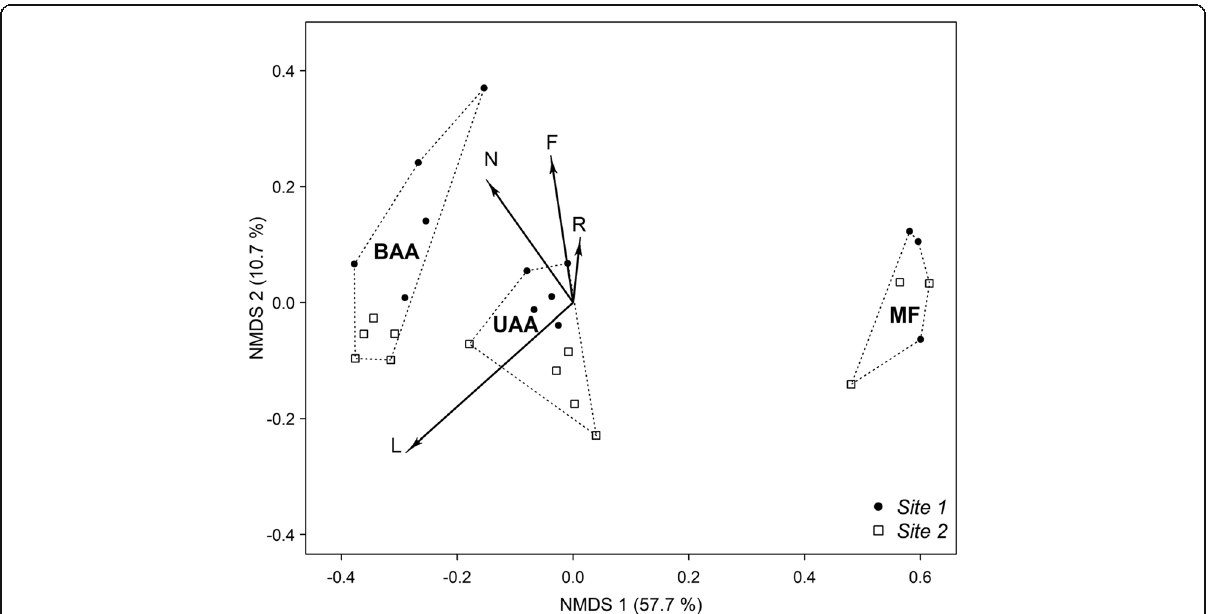
Fig. 9 NMDS ordination of the vegetation data. The fitted vectors (full-line arrows) show the direction and strength of the linear correlations of the Landolt indicator values with the plot scores. F soil moisture, L insolation, N nutrient content in the soil, and R soil reaction. The biotopes are indicated by convex hulls (dotted lines). UAA unburnt abandoned arable land, BAA burnt abandoned arable land, and MF patches of mature forest. Values in brackets are proportions of variation represented by the axes; stress is 0.11